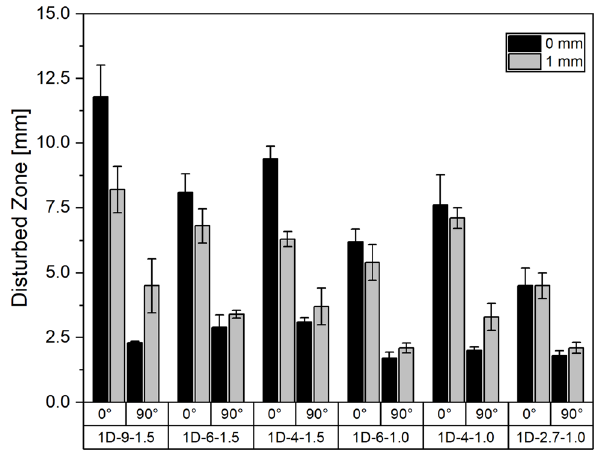
Figure 9: Measured dimension of disturbed zones at the surface and at a depth of 1 mm in 0° and 90° in relation to the initial fi ber